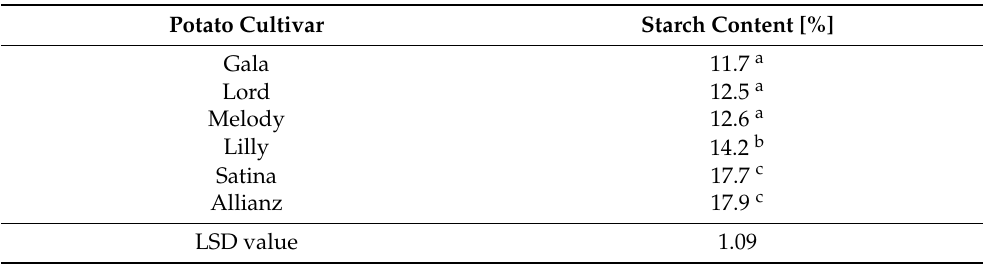
Table 2. Starch contents of cold-stored potatoes of 6 cultivars assessed chemically (homogeneous groups are labeled with the letters).